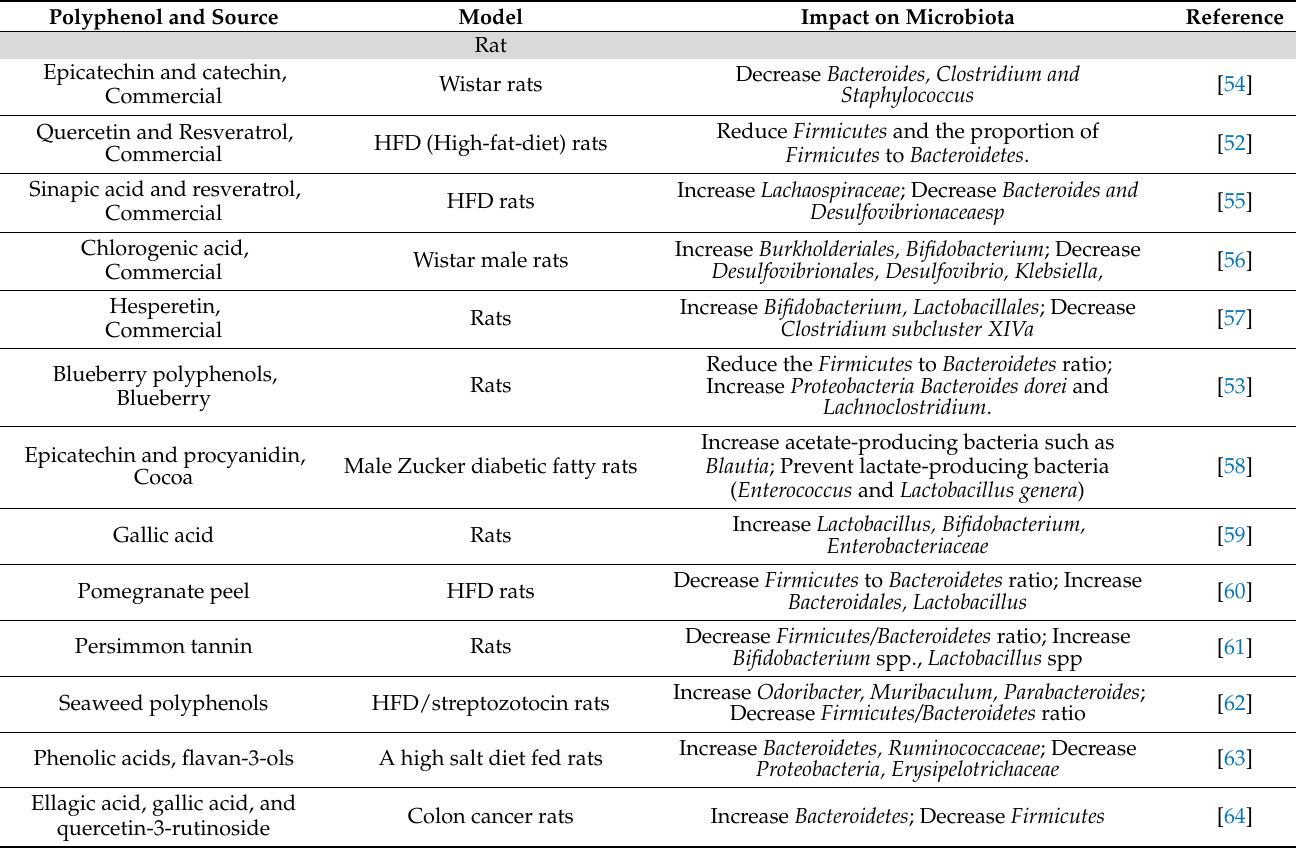
Table 2. Effect of polyphenols on animal gut